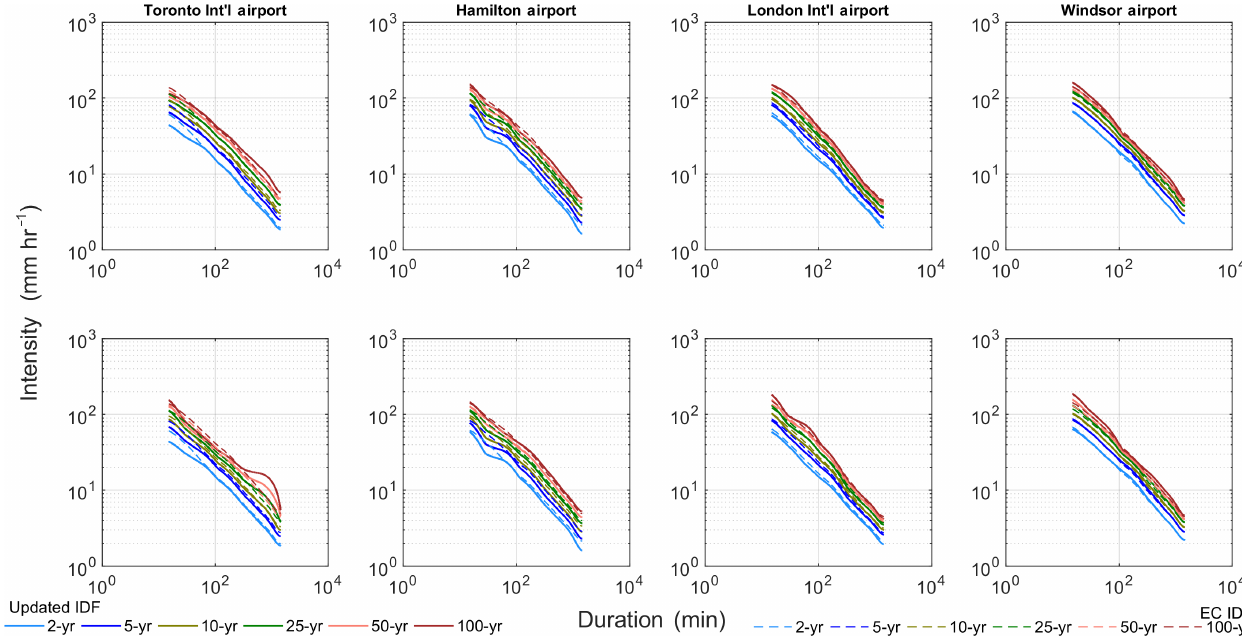
Figure 8. Estimated nonstationary vs. EC-generated IDFs for T = 2-, 5-, 10-, 25-, 50- and 100-year return periods for the selected urbanized locations in Southern Ontario, Canada. The updated and EC IDFs are shown using solid and dotted lines